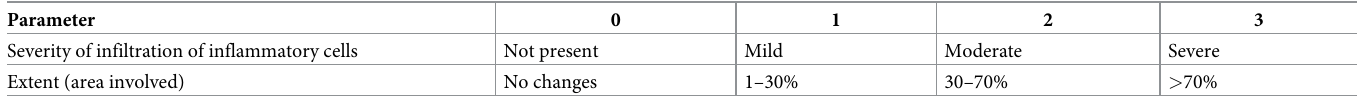
The total inflammation score is the sum of the two component scores, thus ranging from 0 to